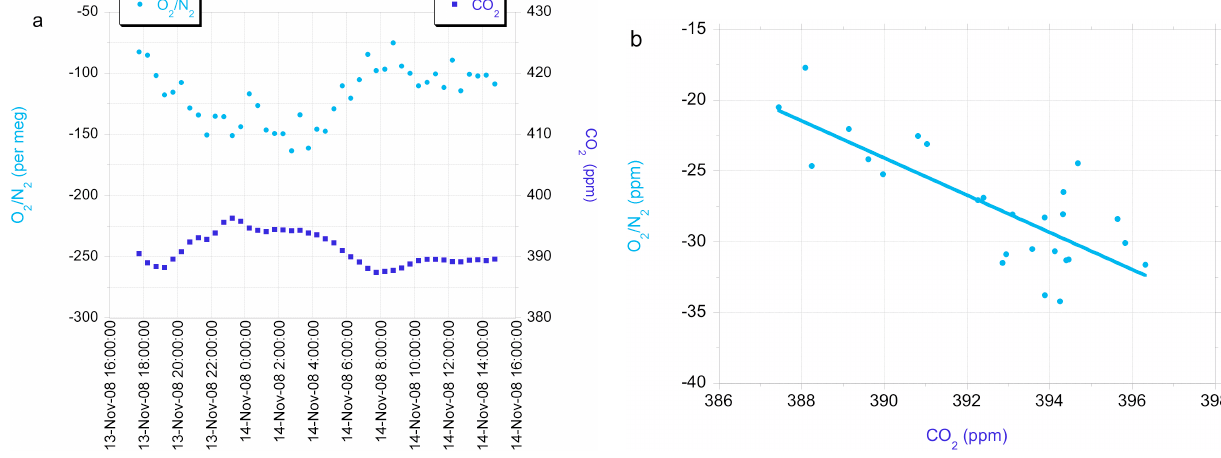
Fig. 7. Observations at the F3 platform for δ O 2 /N 2 (lighter circles) and CO 2 (darker squares) on 13 and 14 November 2008 (a) and correlation between δ O 2 /N 2 and CO 2 during the peak (b) . The linear fit shown in (b) yields a slope of − 1 . 31 ± 0 . 09 ( R 2 =0.61).